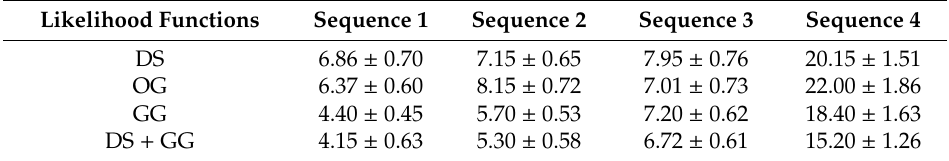
Table 3. The Mean localization error in the image (pixels) of different sequences in the database. Likelihood Functions